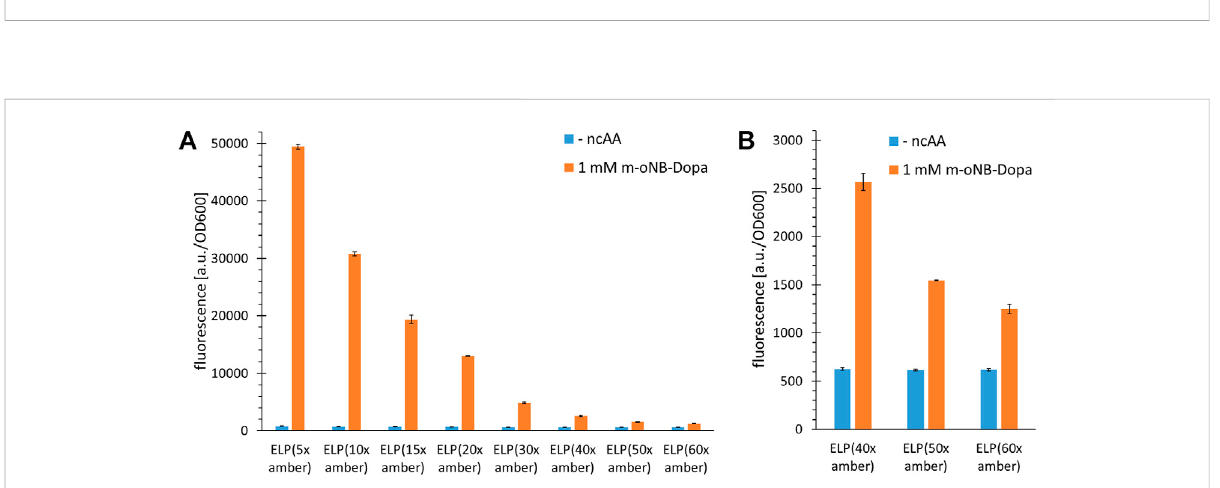
FIGURE 3 Incorporation ef fi ciency of m - o NB-Dopa for increasing numbers of installation sites in ELP constructs. Stop codon suppression and OTS constructs as indicated in the main text, see Supplementary Material for sequence details. (A) Ribosomal incorporation of m - o NB-Dopa (1 mM) with ELP constructs containing a varying number (5 – 60) of in-frame amber stop codons. Controls lack ncAA supplementation (- ncAA). (B) Data extract with focus on the suppression of 40, 50 and 60 in-frame stop codons for ncAA incorporation. Intact cell fl uorescence of E. coli B-95. Δ A (RF1 de fi cient strain), endpoint measurements after 18 h of incubation. Fluorescence values were normalized with corresponding OD 600 values to correct for differences in cell density. Data (incl. Standard deviation) represent the mean of three biological